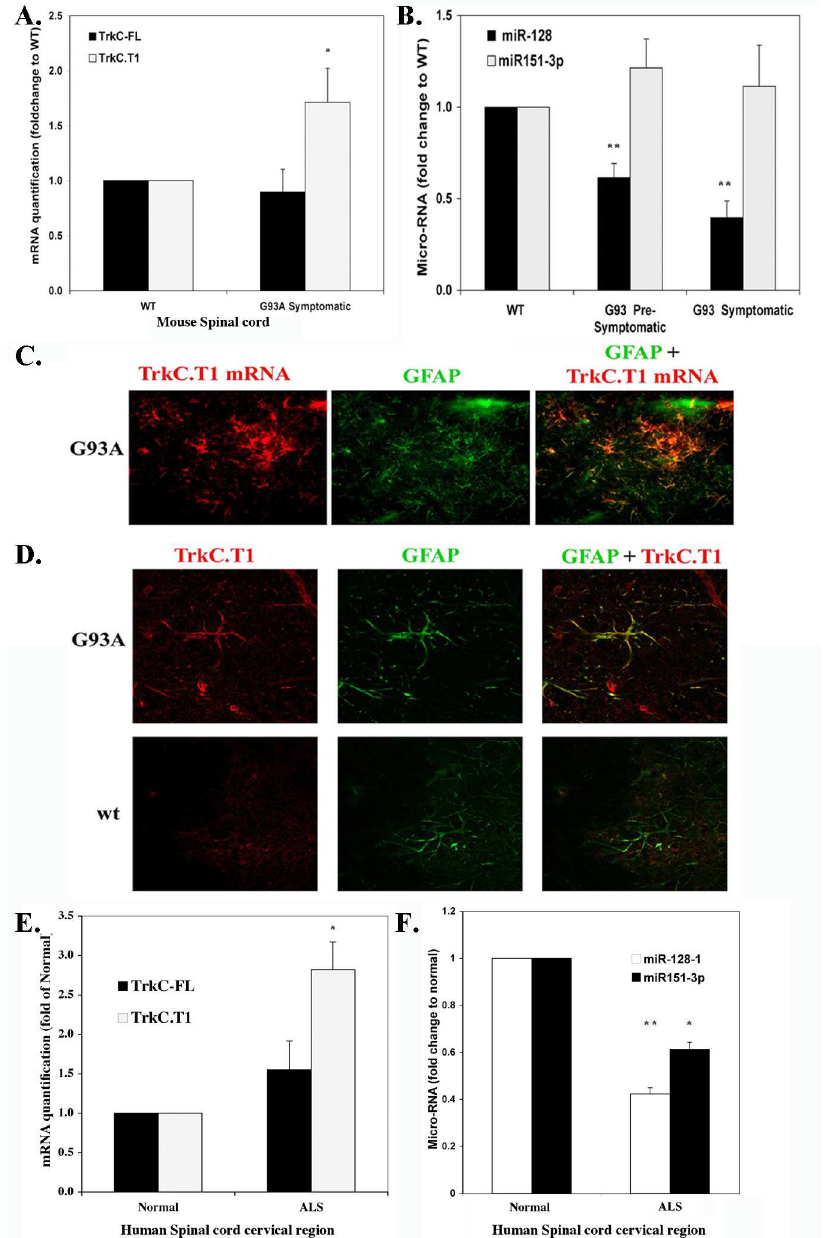
Fig 4. TrkC.T1 expression is up-regulated whereas miR-128 expression is down-regulated in the spinal cord of ALS G93A mice and in human SALS. (A) The mRNA levels of TrkC-FL and TrkC.T1 were assessed by quantitative PCR with SYBR Green (Quanta), normalizedto GAPDH or β -tubulinIII, for WT mice or ALS mice. Data are expressed as the mean + SEM (n = 8 spinal cord samples each group (B) The levels of miR-128 (regulator of TrkC.T1) and miR-151-3p (regulator of TrkC-FL) were measured by SYBR Green qRT-PCR (Quanta) and results were normalizedto the reference RNU6 (small nuclear RNA). Data are expressedas the mean + SEM. (C) Combinedfluorescent in situ mRNA hybridization (red, for TrkC.T1 mRNA) with immunofluorecence (green, GFAP marker). 40x magnification of 20 μ m-thick sections of the lumbar spinal cord of G93A ALS mice. The probe specific for TrkC.T1 encompasses exons 13b & 14b as well as some of the 3’UTR. (D) Co-localization of TrkC.T1 protein (using anti-TrkC.T1 antibody 750) and GFAP in 12 μ m thick sections from G93A ALS mice (top panels) or wild type mice (bottom panels). Pictures were taken using a Leica confocal microscope with 63x magnification. (E) The mRNA levels of TrkC-FL and TrkC. T1 were assessed by quantitativePCR with SYBR Green (Quanta), normalized to β -tubulin III, for